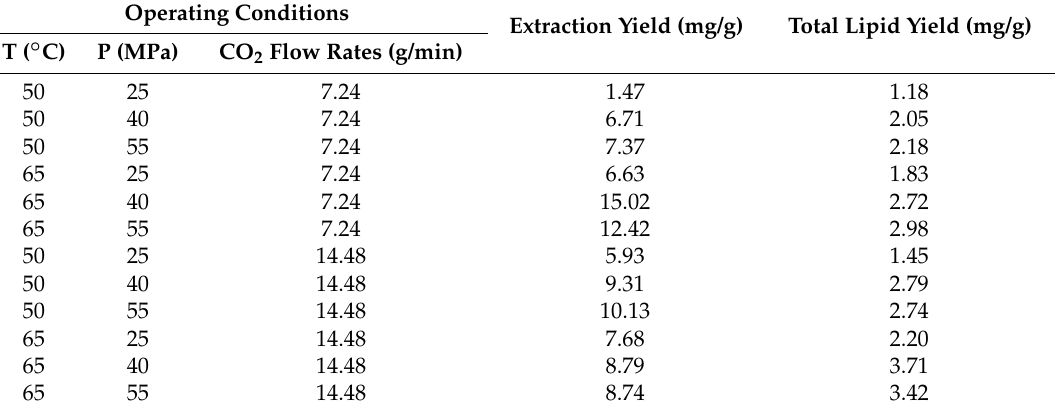
Table 1. Effect of SF-CO 2 operating conditions on extraction and lipid yield from S. almeriensis pretreated